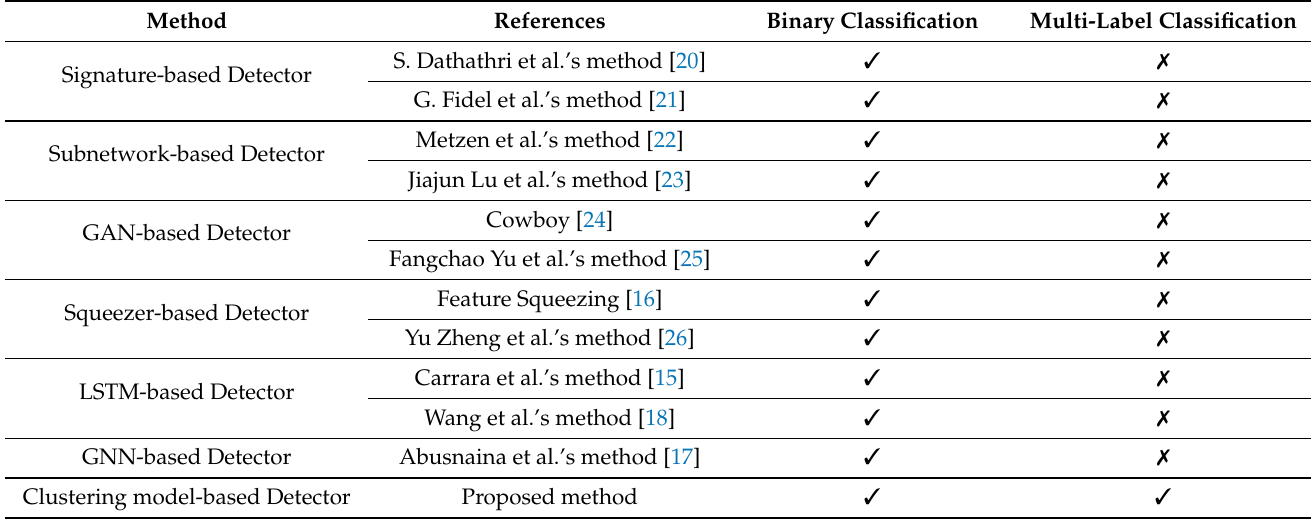
Table 1. Summary of the recent defense methods using adversarial example detection architecture. Most of the methods cannot classify the input data into multiple classes of